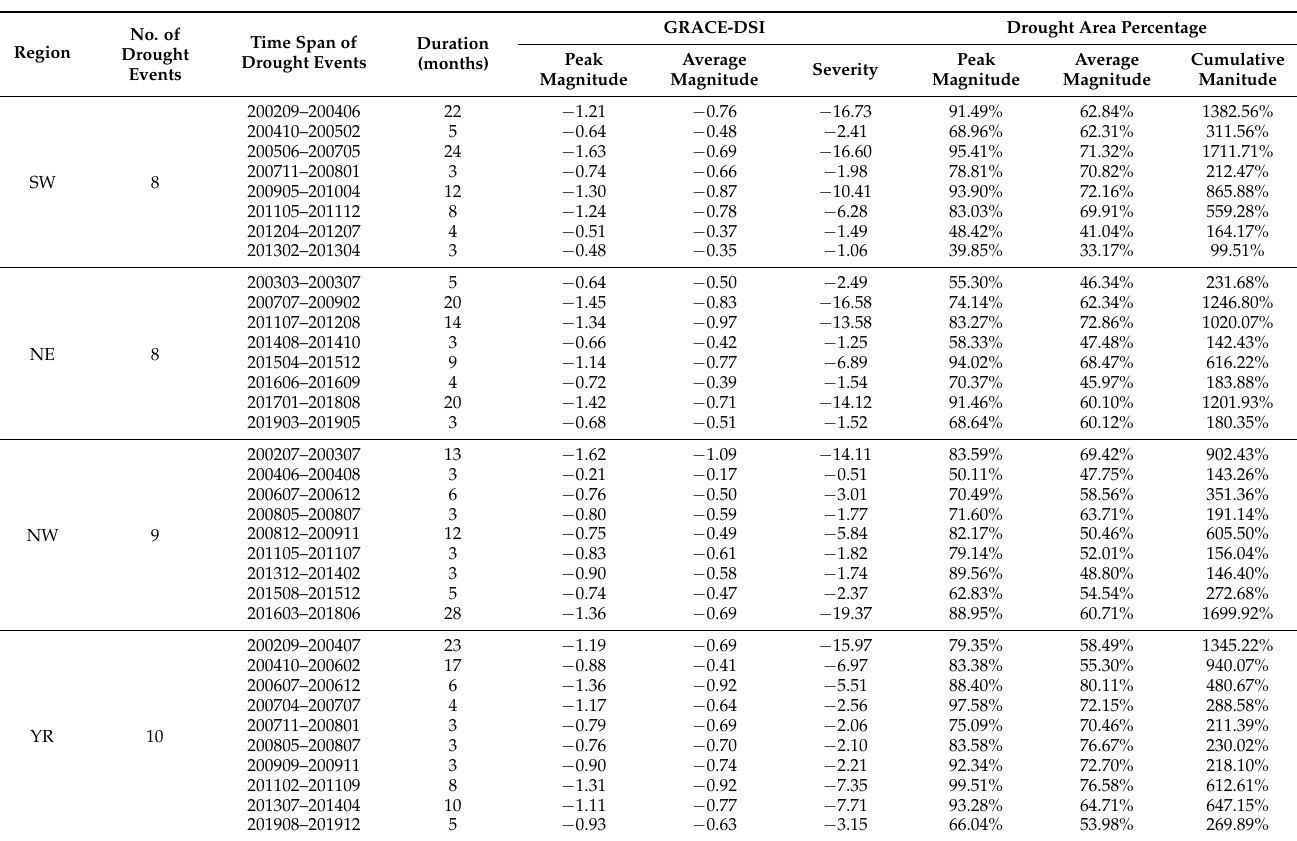
Figure 8. Drought events (drought duration, drought severity, and drought-affected area) determined by the calibrated approach in Mainland China during April 2002 and July 2020. Table 8. Summary table of drought events identified by the calibrated